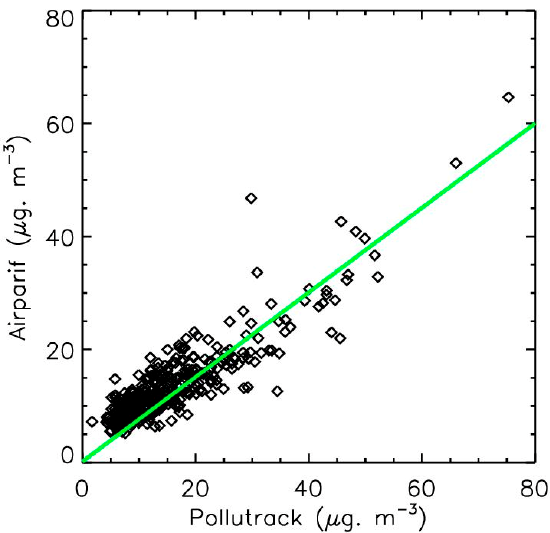
Figure 8. Correlation plot between Pollutrack and Airparif daily averaged PM2.5 measurements. The correlation is of 0.88.